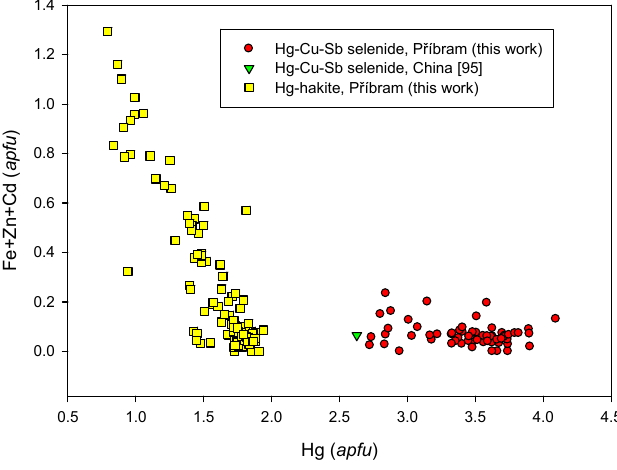
Figure 67. Hg ( apfu ) vs. vacancies pfu graph for unnamed Hg-Cu-Sb selenide and Hg-hakite; vacancies were calculated as 12-(Cu + Ag + Tl + Hg + Fe + Zn + Cd). Minerals 2017 , 7 , 91